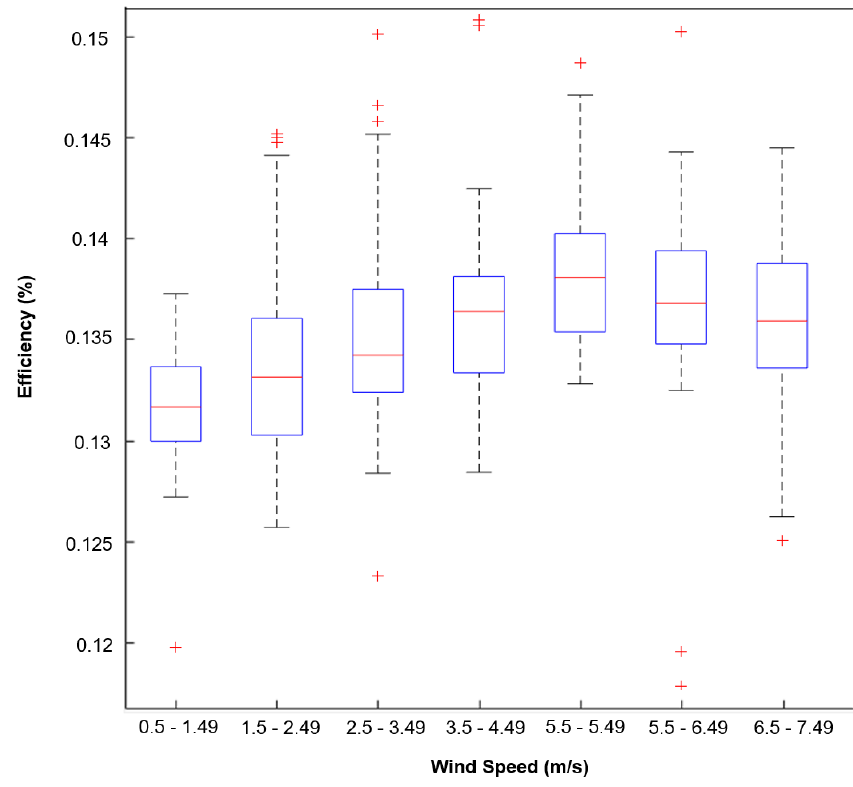
Figure 11. Array efficiency at different wind